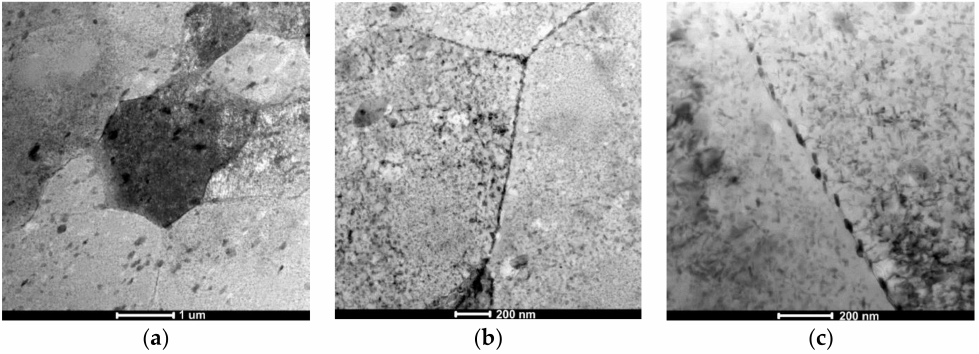
Figure 6. The AlZn6Mg0.8Zr alloy after LTTT with 10% deformation: ( a ) α solution matrix with nonuniform distribution of precipitates; ( b ) fine chain-arranged particles along grain boundaries; ( c ) PFZ along grain boundary with precipitates.